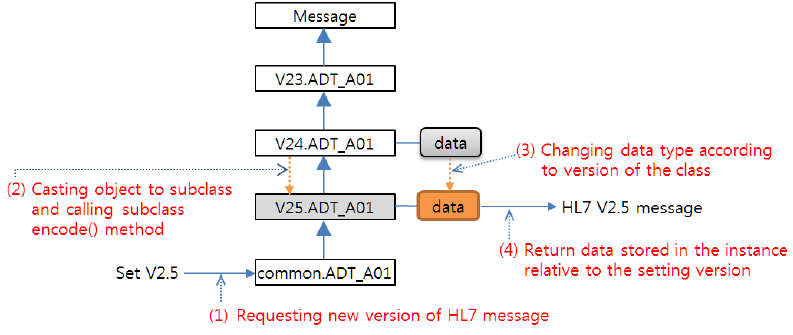
Fig. 9. Encoding procedure of an HL7 message for forward compatibility.